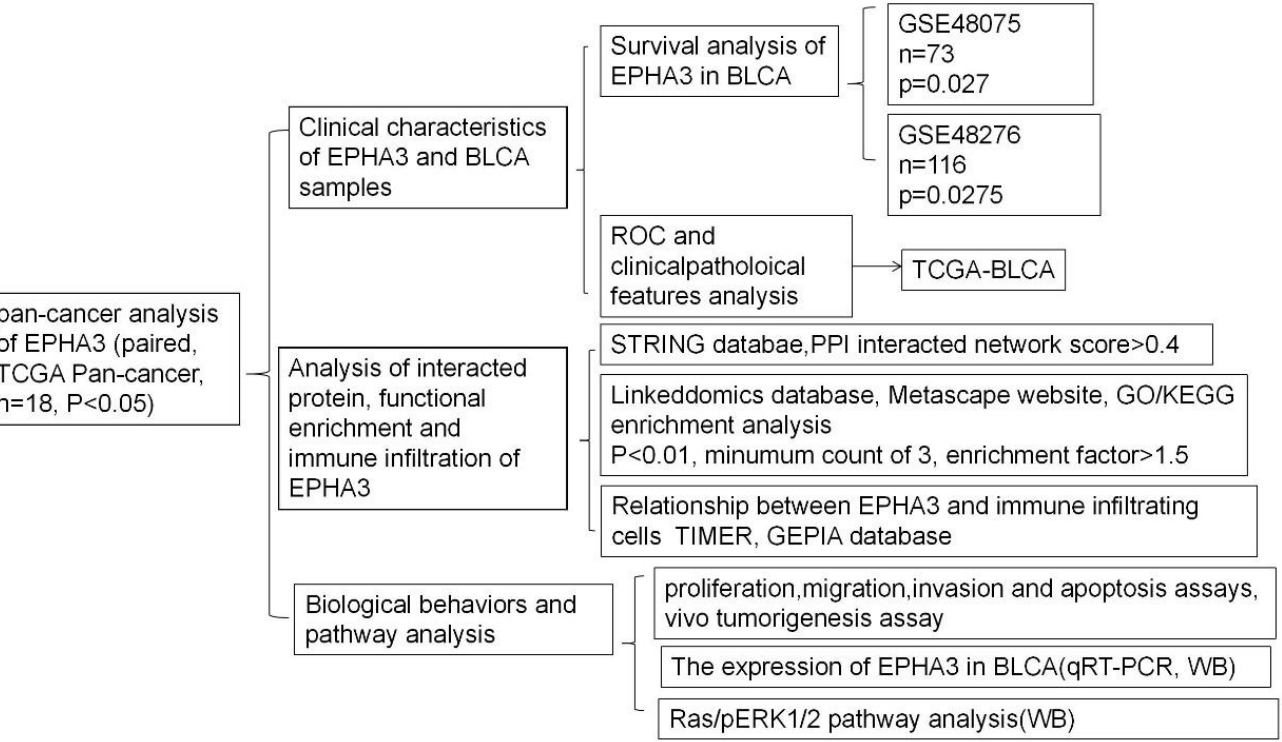
Figure 1. Flowchart showing the research used in this study.